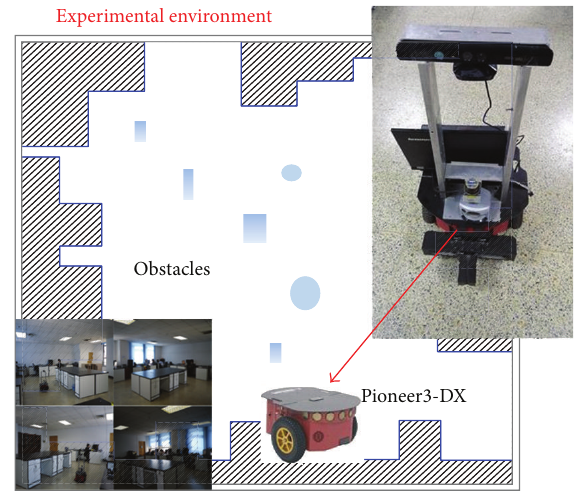
Figure 7: System hardware platform for environment